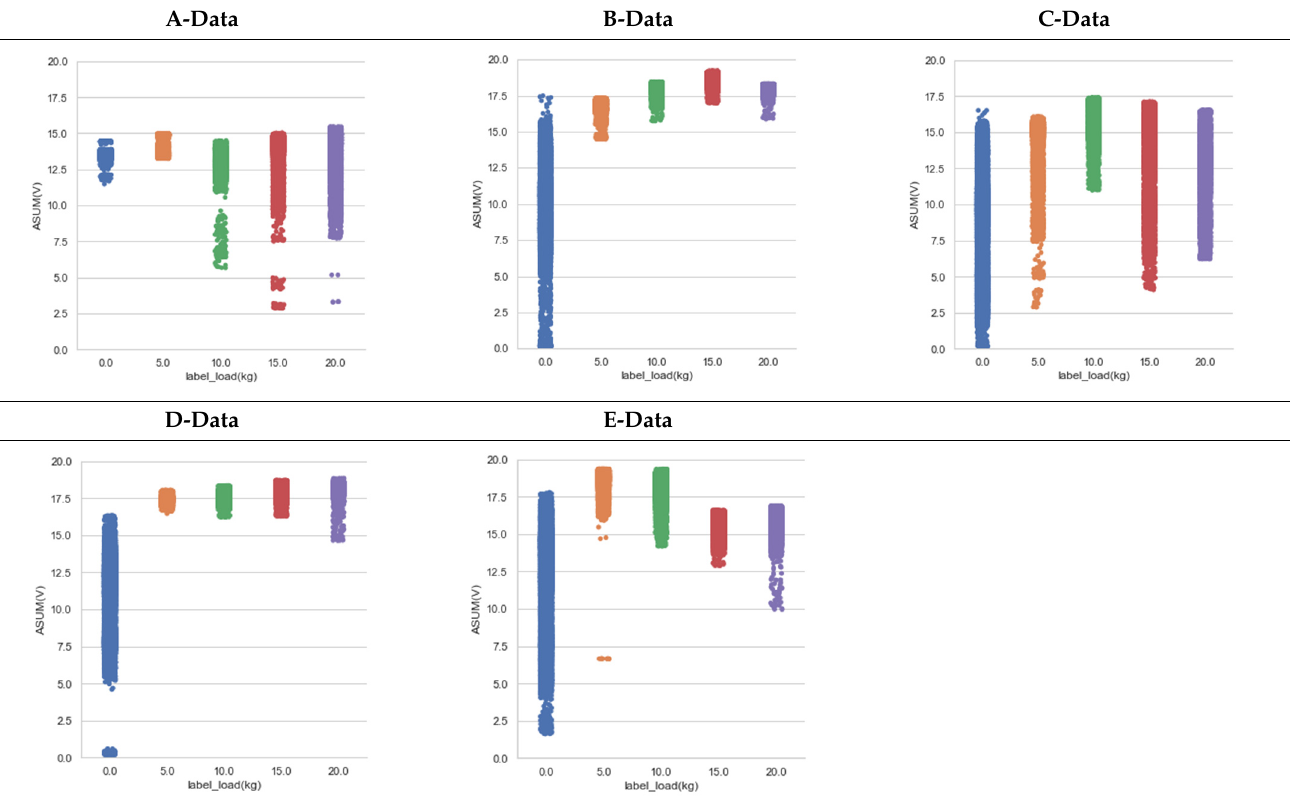
Table 4. Scatter diagrams between the ASUM and Load by each experimenter.